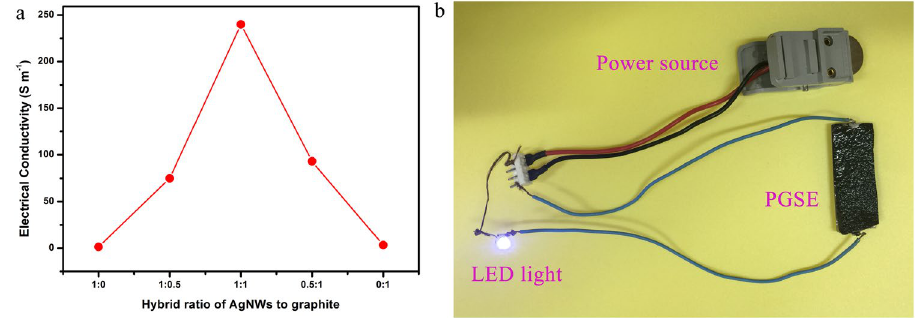
Figure 7. ( a ) Electrical conductivity variation of the PGS with a volume ratio of AgNWs/graphite (1:0, 1:0.5, 1:1, 0.5:1, 0:1). ( b ) Optical image of the LED light when connecting the PGSE composites with 10 wt% graphite sheets and 3 wt% AgNWs in the circuit.